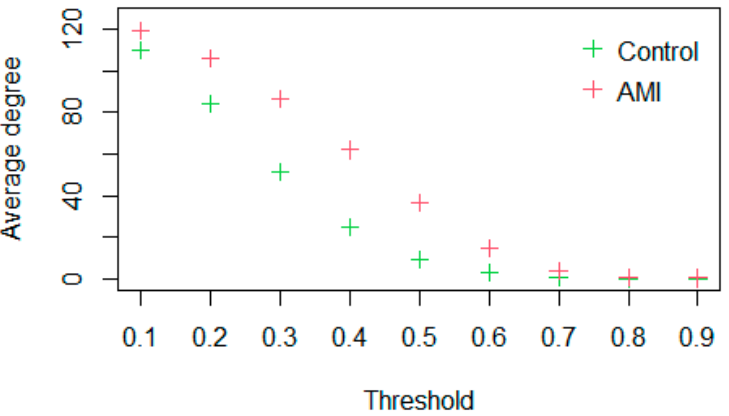
Figure 6. Network assessment. Networks in the control and AMI groups are separable according to the average degree of